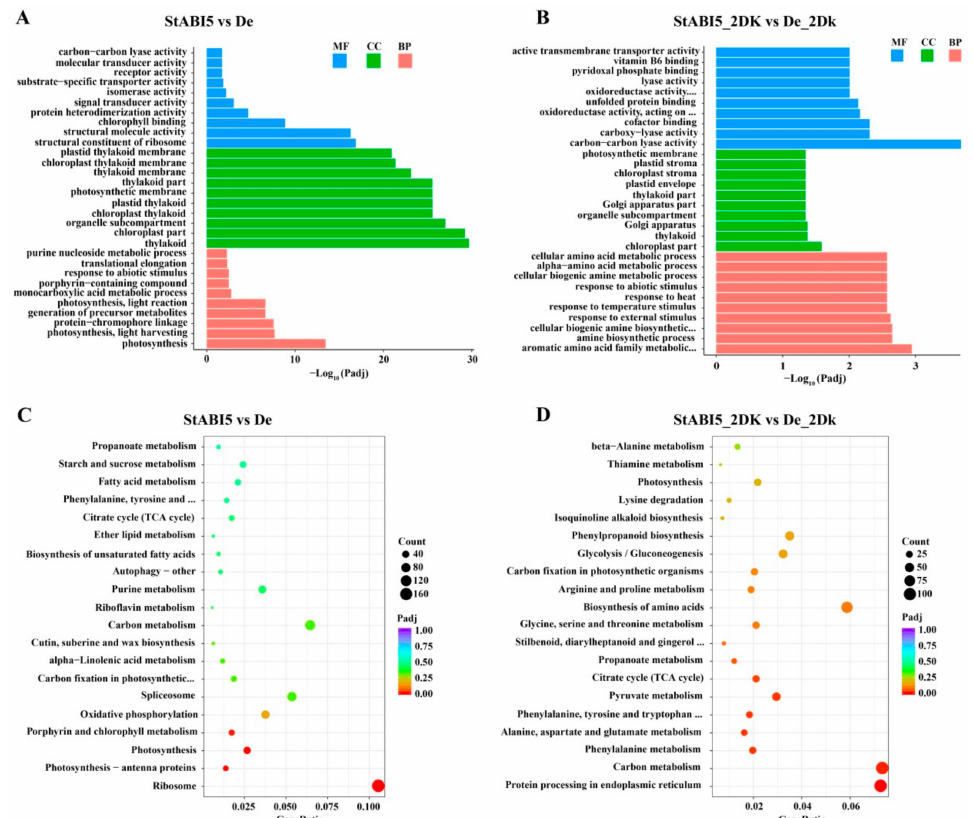
Figure 5. Gene ontology (GO) and KEGG pathway enrichment analysis of differentially expressed genes (DEGs). ( A ) The top 30 most enriched GO terms found in the analysis of DEGs in StABI5 vs. De group. Different colors represent molecular functions (MF), cellular components (CC), and biological processes (BP). Gene ontologies were ranked by their significance. ( B ) The top 30 most enriched GO terms found in the analysis of DEGs in StABI5_2DK vs. De_2Dk group. ( C ) The top 20 functionally enriched KEGG pathways found in the analysis of DEGs in StABI5 vs. De group. ( D ) The top 20 functionally enriched KEGG pathways found in the analysis of DEGs in StABI5_2DK vs. De_2Dk